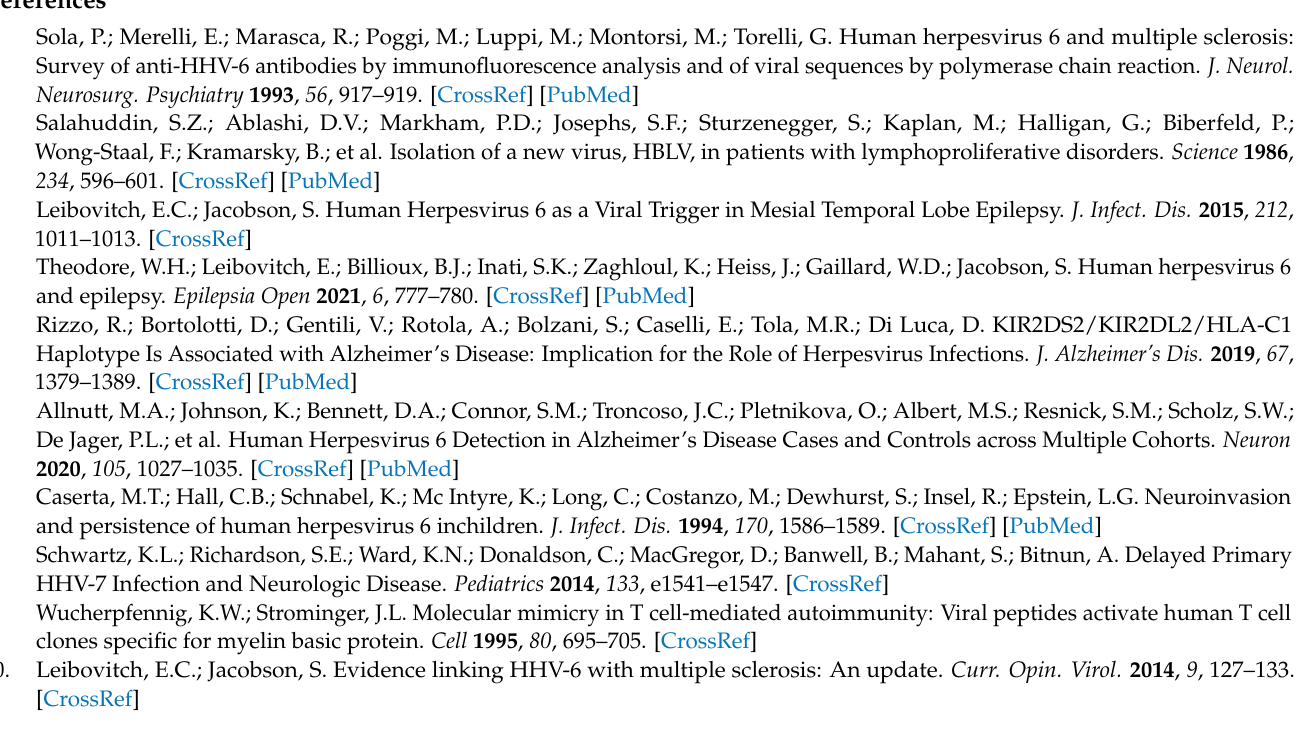
U24-6B peptide. Figure S2: ITC and NMR titration results for U24-6A ∆ MD (U24-6A, residues 3 to 15, Table 1) and Fyn-SH3 domain. Figure S3: Structural models for the binding interaction between (a) U24 and (b) pU24 and hNedd4L-WW3. Table S1: Sequences and molecular weights (MW) of human Fyn-SH3 (Uniprot P06241; residue 82-142 underlined) and hNedd4L-WW3* (Uniprot Q96PU5; residues 497-530 underlined) used in this study. Table S2: Primer sequences and PCR conditions used to generate Nedd4L and the GAPDH